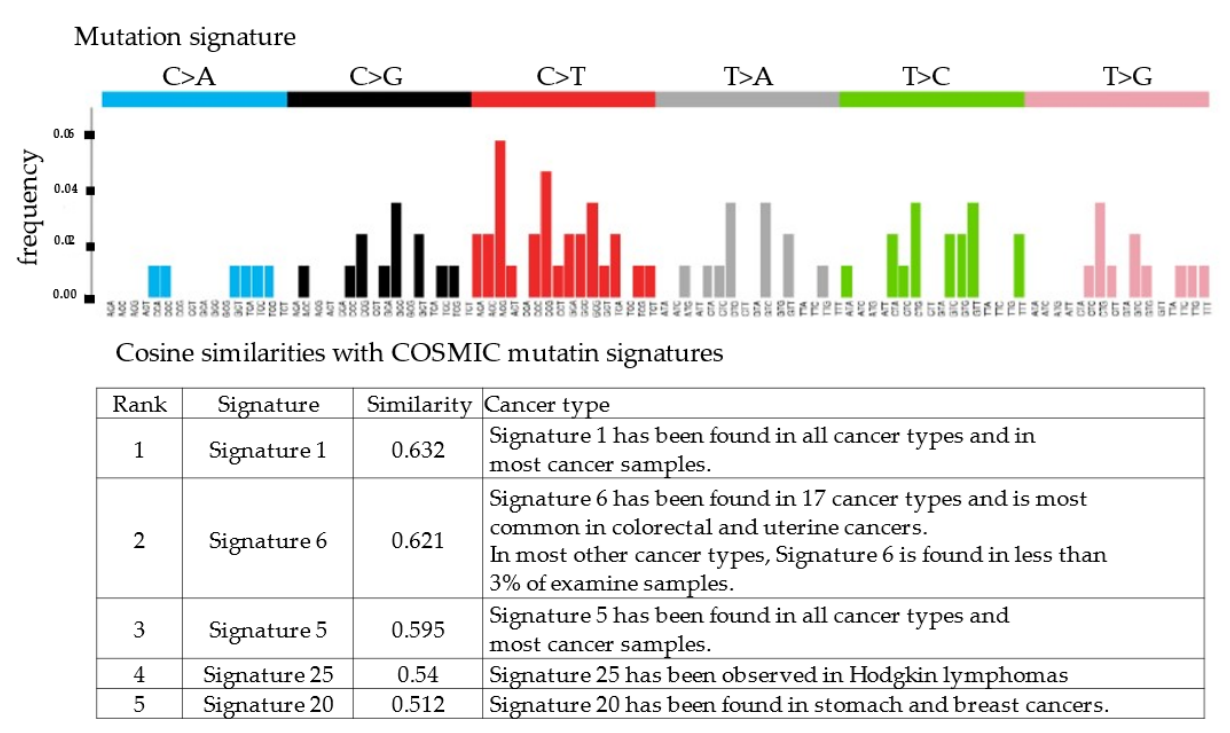
Figure 5. Cosine similarities with COSMIC mutation signatures. Signature 1 showed the highest similarities with the mutation profile of the patient.